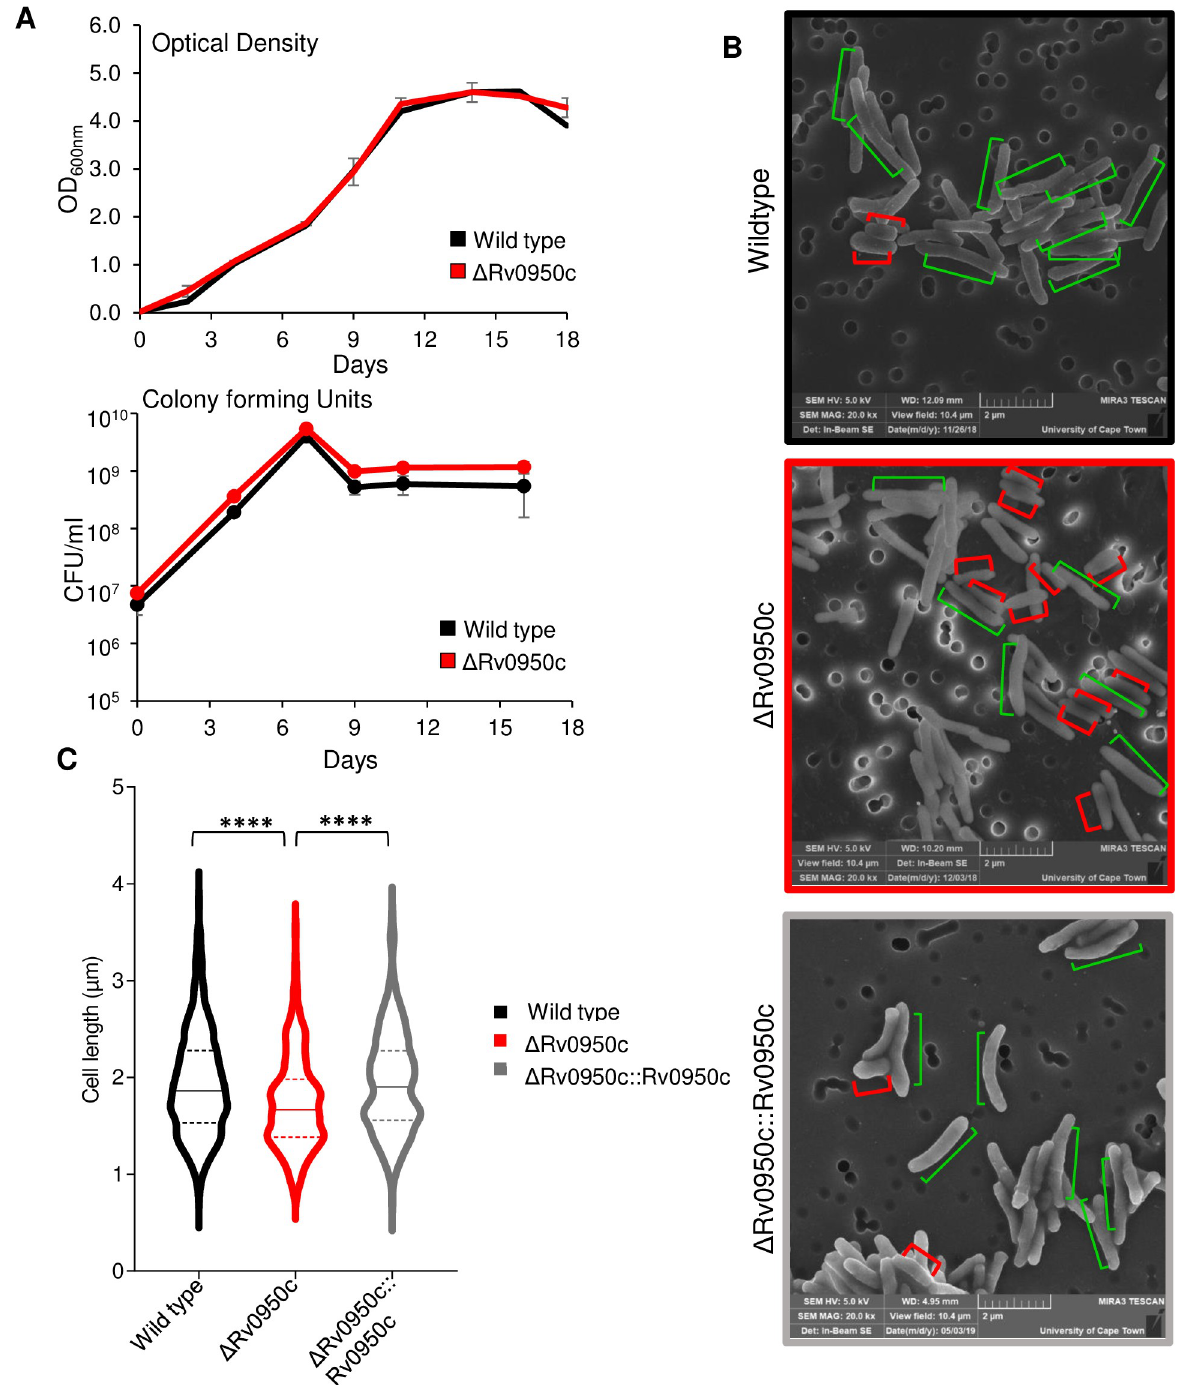
Fig 3. Deletion of Rv0950c does not affect growth but causes cell shortening in M . tuberculosis . A) Growth analysis of the Δ Rv0950c mutant using optical density (upper panel) and colony forming unit (bottom panel). Deletion of Rv0950c resulted in no growth defects in broth culture B) Representative SEM micrographs of wild type, Δ Rv0950c, and Δ Rv0950c::Rv0950c genetically complemented derivative, emphasising normal cells of ~ 2 μ m (green bars) and short cells of ~ 1 μ m (red bars). Scale bar = 2 μ m. C) Violin plot of cell lengths measured in ImageJ of 100 cells for each strain in triplicate. ���� p < 0.05E -7 for t-test calculated in Excel.